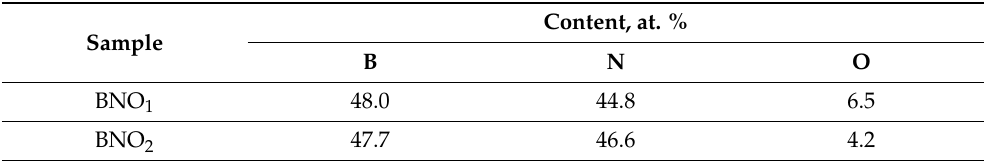
Table 1. Elemental composition of BNO x samples synthesized at 650 (BNO 1 ) and 1100 ◦ C (BNO 2 ). The rest is carbon from adsorbed carbonaceous